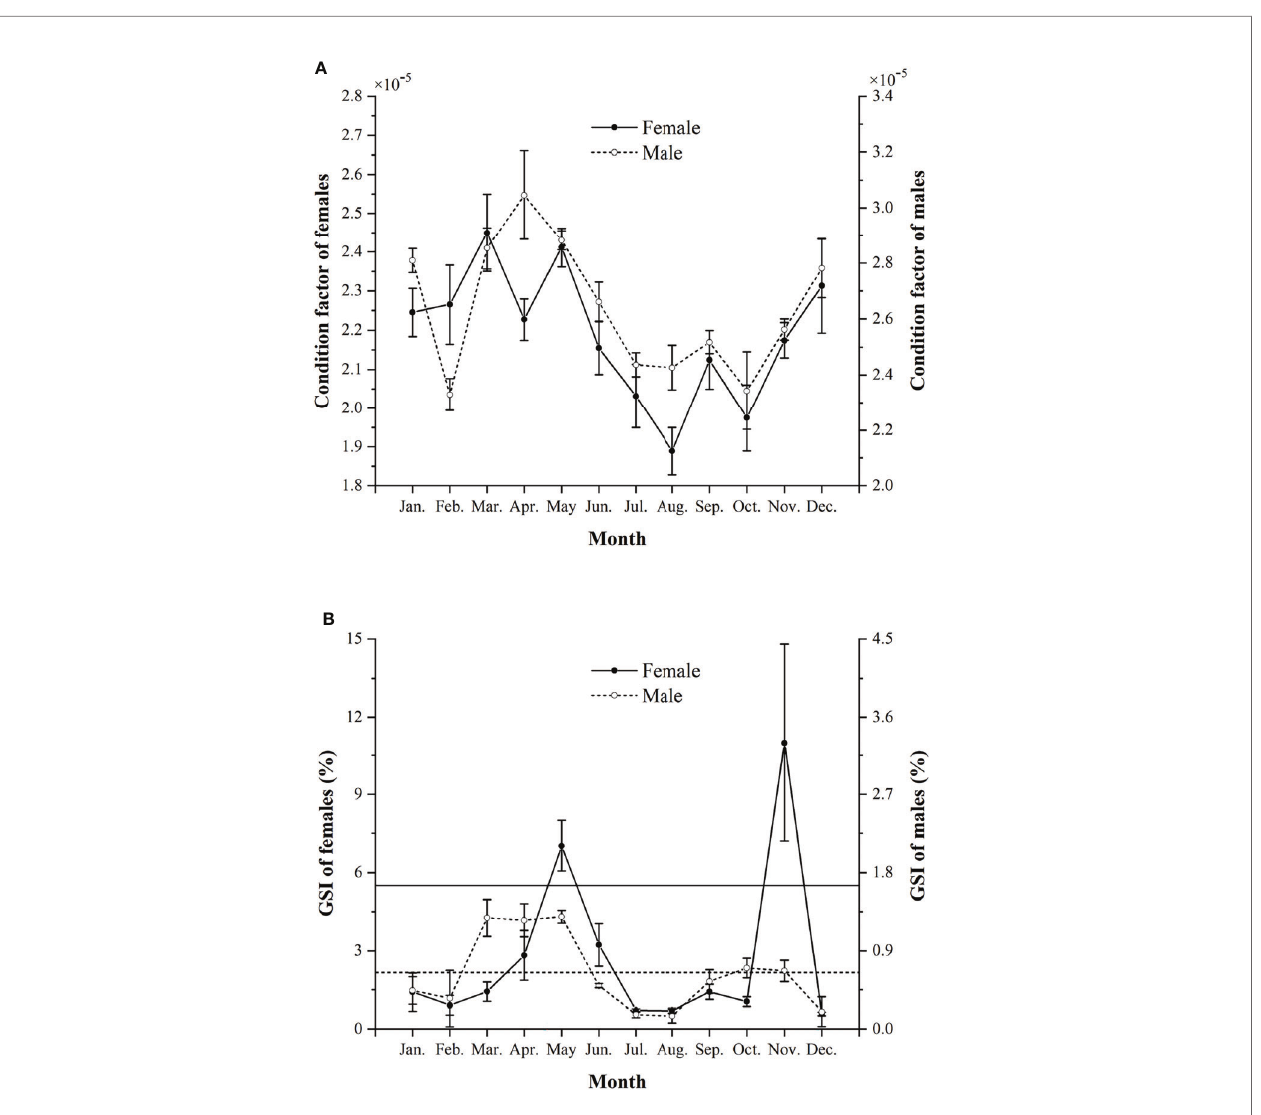
FIGURE 4 | Monthly condition factors (mean ± SD) (A) and monthly gonadosomatic index (GSI %, mean ± SD) (B) in females and males of Larimichthys crocea from April 2019 to November 2021. Horizontal solid and dashed lines indicate the 50% of the maximum GSI% for females and males,